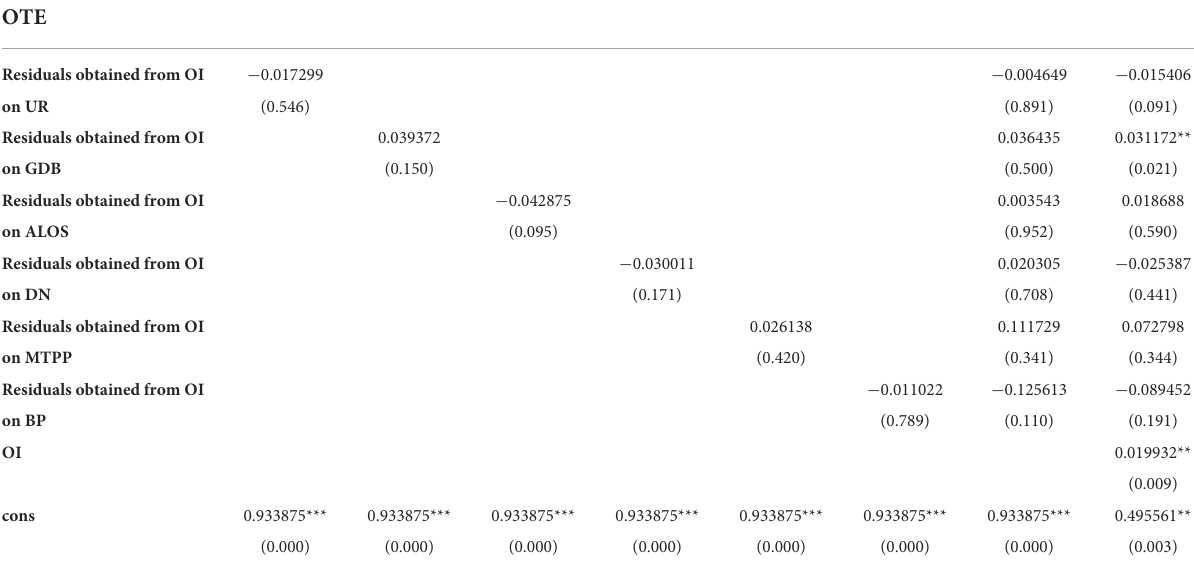
TABLE 8 Results of bootstrapping truncated regression for tertiary hospitals: estimations of the residuals from OI.